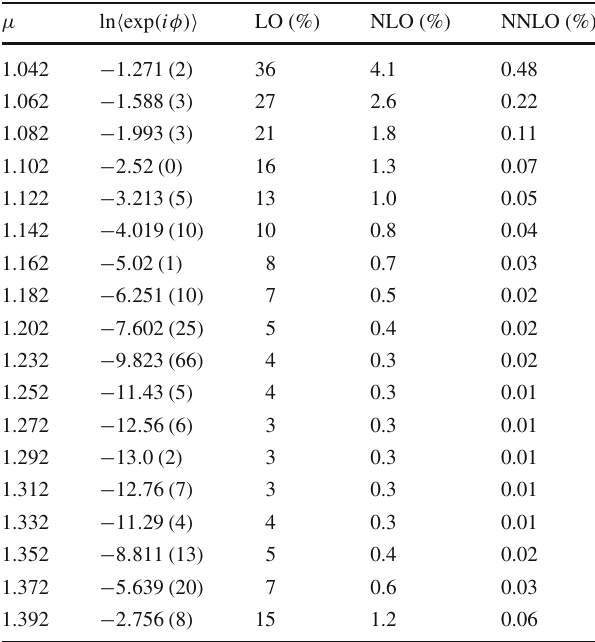
Table 5 Logarithm of the phase factor expectation value from [16] and relative precision obtained with the moment method for the various orders as a function of